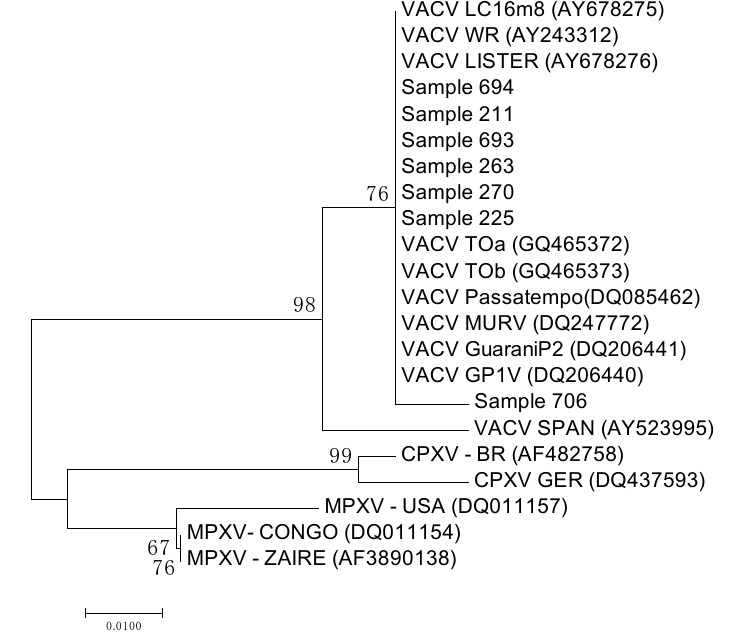
Figure 2. Phylogenetic tree based on the OPV nucleotide sequence of the vgf gene showing blood samples cluster (Sample 694, Sample 211, Sample 693, Sample 263, Sample 270, Sample 225, Sample 706). Sample 694 = blood sample of Didelphis aurita; Sample 211 = blood sample of cow; Sample 693 = blood sample of Didelphis aurita; Sample 263 = blood sample of cow; Sample 270 = blood sample of horse; Sample 225 = blood sample of cow; Sample 706 = blood sample of Didelphis albiventris .